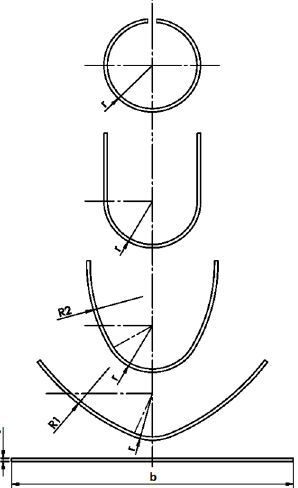
Figure 1. Technological process of seam tube production through a bending process.